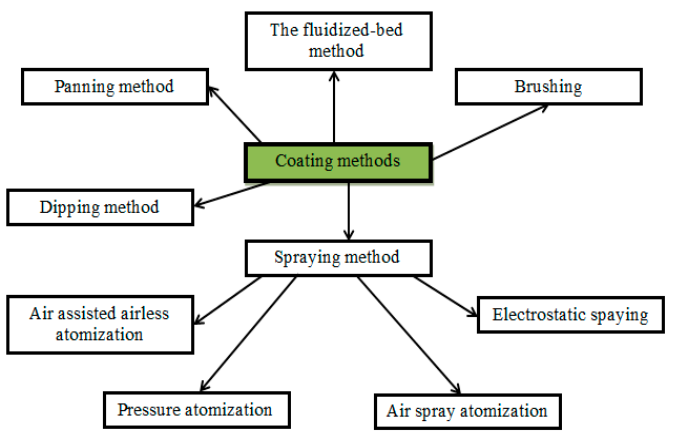
Figure 13. Coating Figure 13. Coating methods.